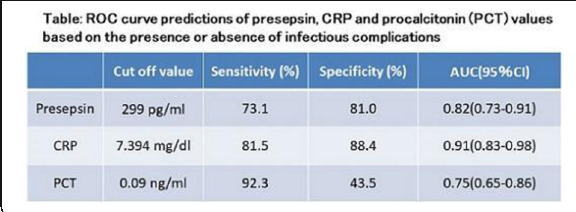
Table 1 (abstract 0238). ROC curve predictions of presepsin, CRP and procalcitonin (PCT)